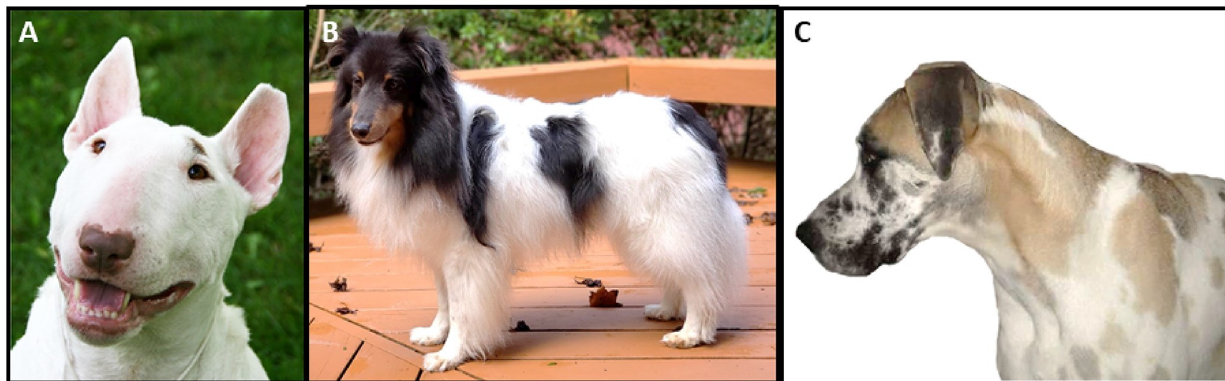
Fig 5. Purebred dogs exhibiting color traits deemed inappropriate by one or more breed registries. A) Bull Terrier with a brown nose and brown patch above its eye. B) Shetland Sheepdog with piebald white spotting. C) Great Dane with the harlequin pattern on a fawn base color.